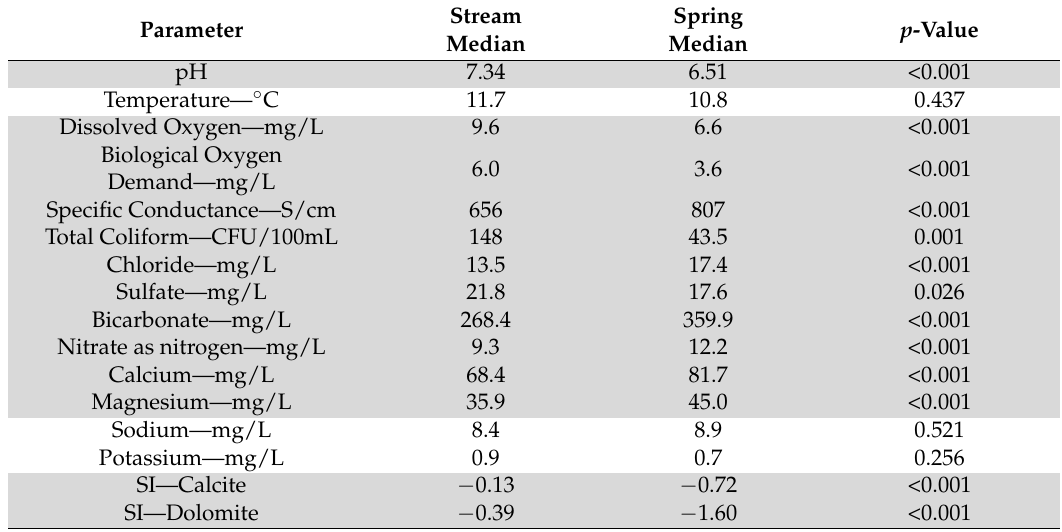
Table 1. p -values from the Mann–Whitney rank sum test between the stream and spring datasets. Cells shaded gray represent parameters with p -values less than